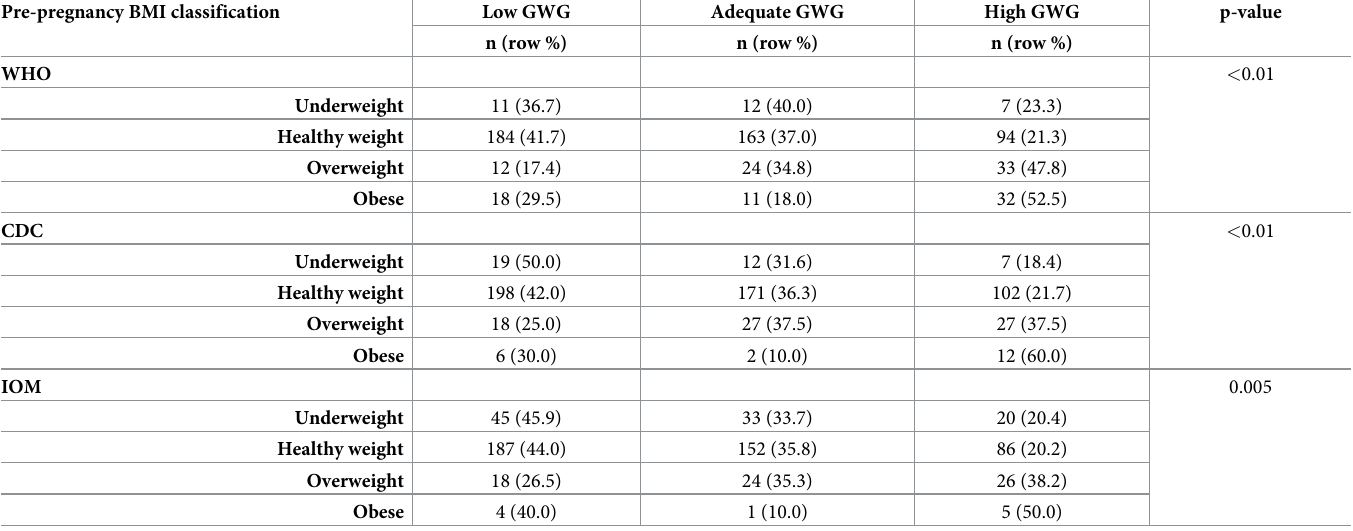
Table 4. Gestational weight gain according to IOM recommendation, by pre-pregnancy BMI classification. Pre-pregnancy BMI classification